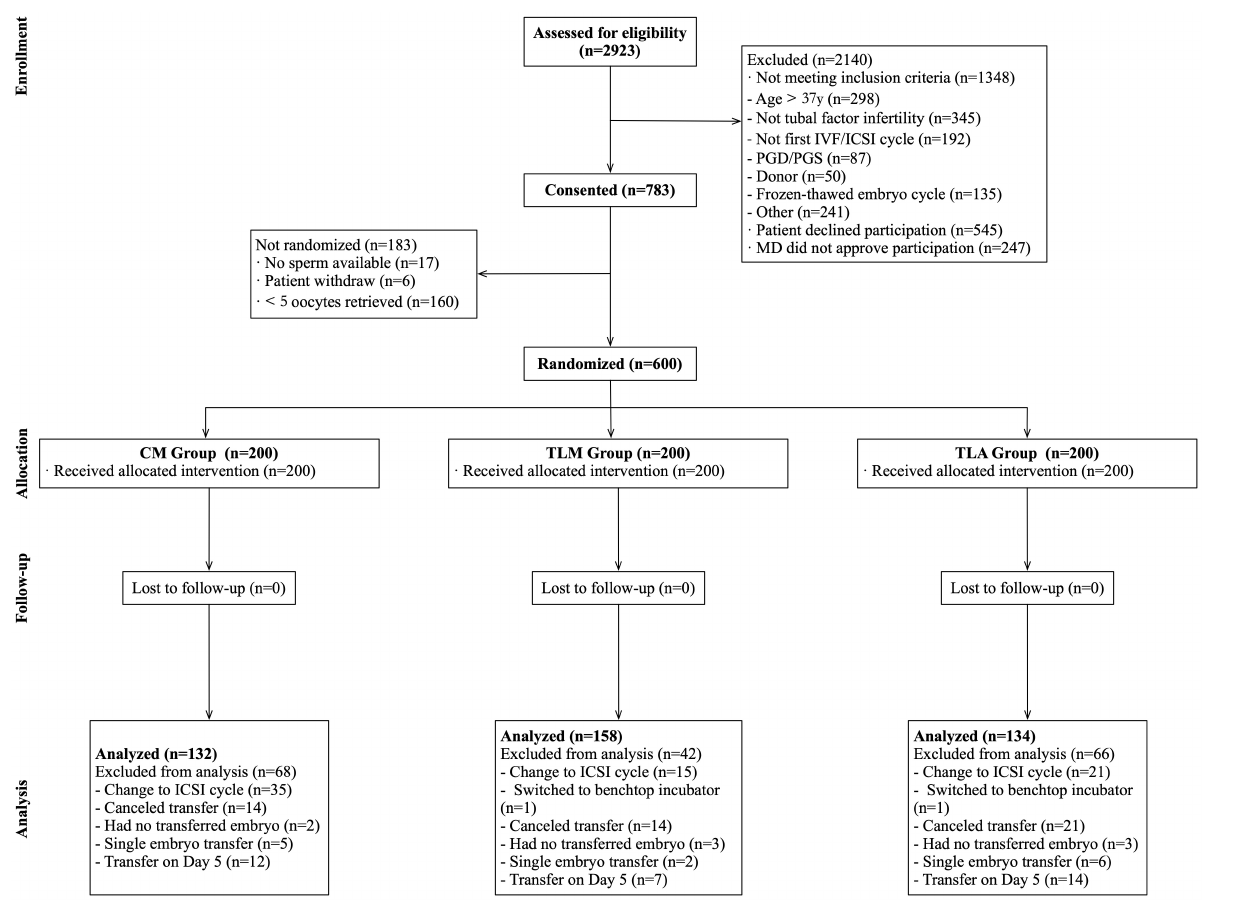
FIGURE 1 | Study flowchart. IVF, in vitro fertilization; ICSI, intracytoplasmic sperm injection; PGD/PGS, preimplantation genetic diagnosis/screening; MD, Doctor of